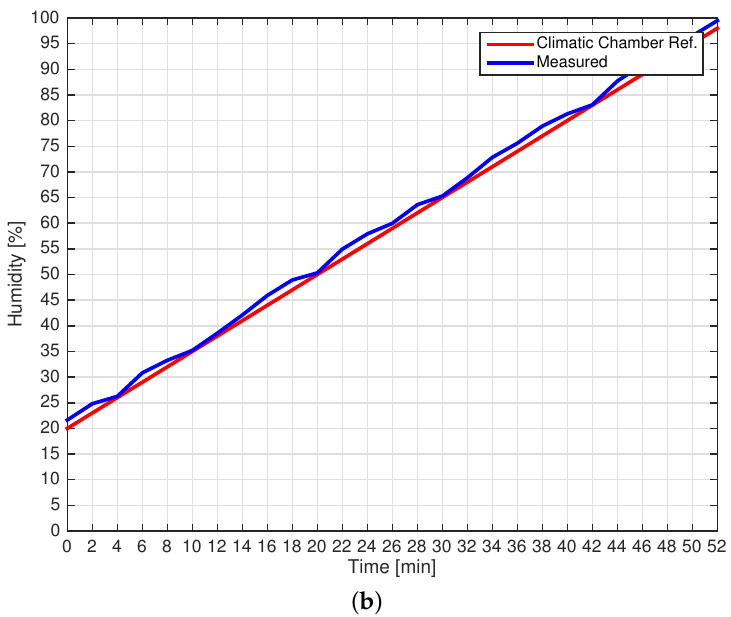
Figure 4. Temperature and humidity calibration curves obtained with a climatic chamber: ( a ) temperature and ( b ) humidity.